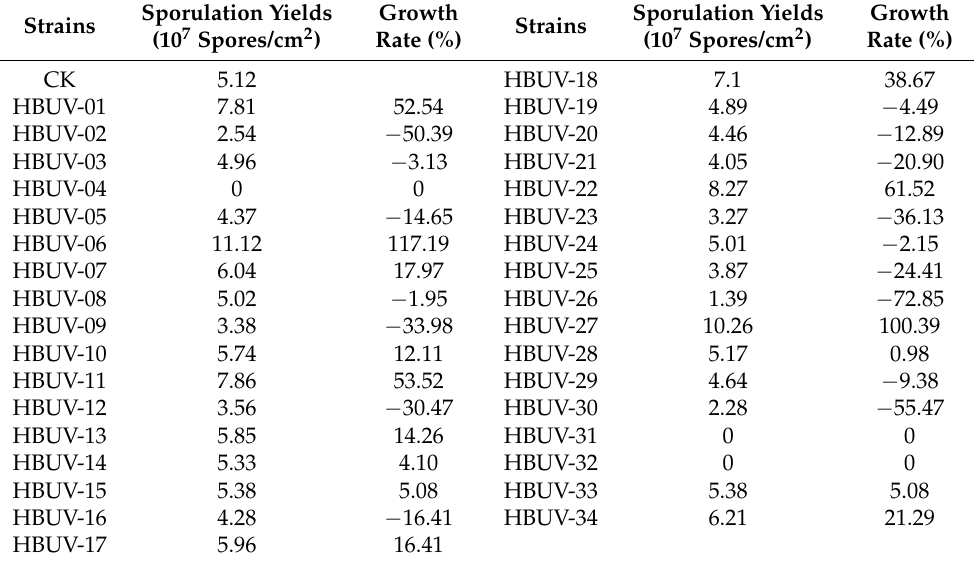
Table 1. Sporulation yields of 34 B. bassiana strains by UV mutagenesis.